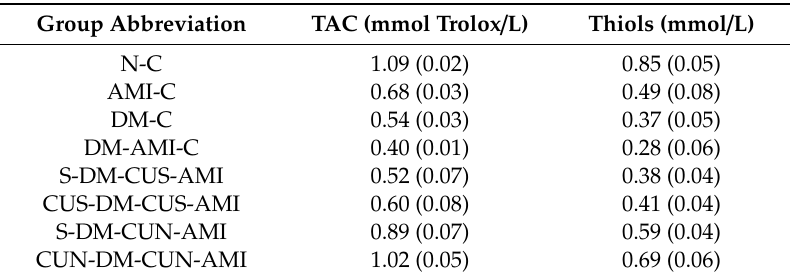
Table 7. Serum levels of antioxidant capacity.